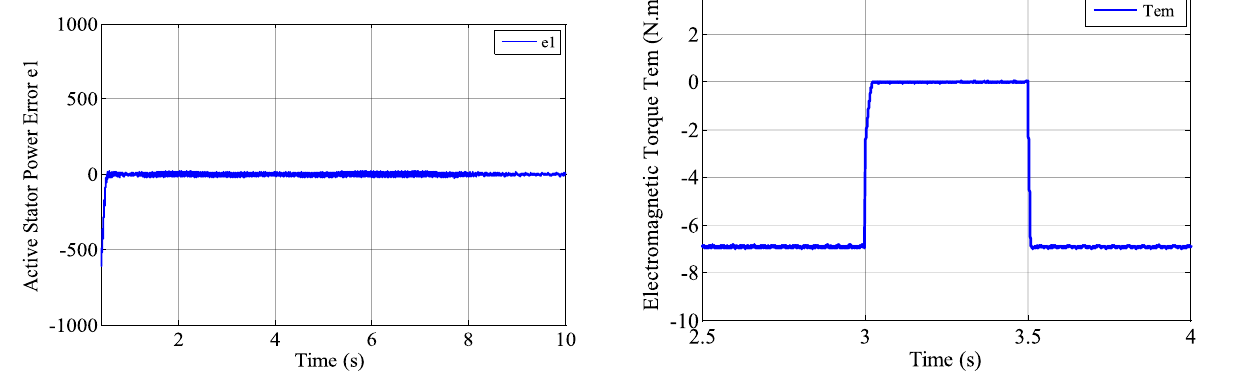
Fig. 15 Electromagnetic Torque T em